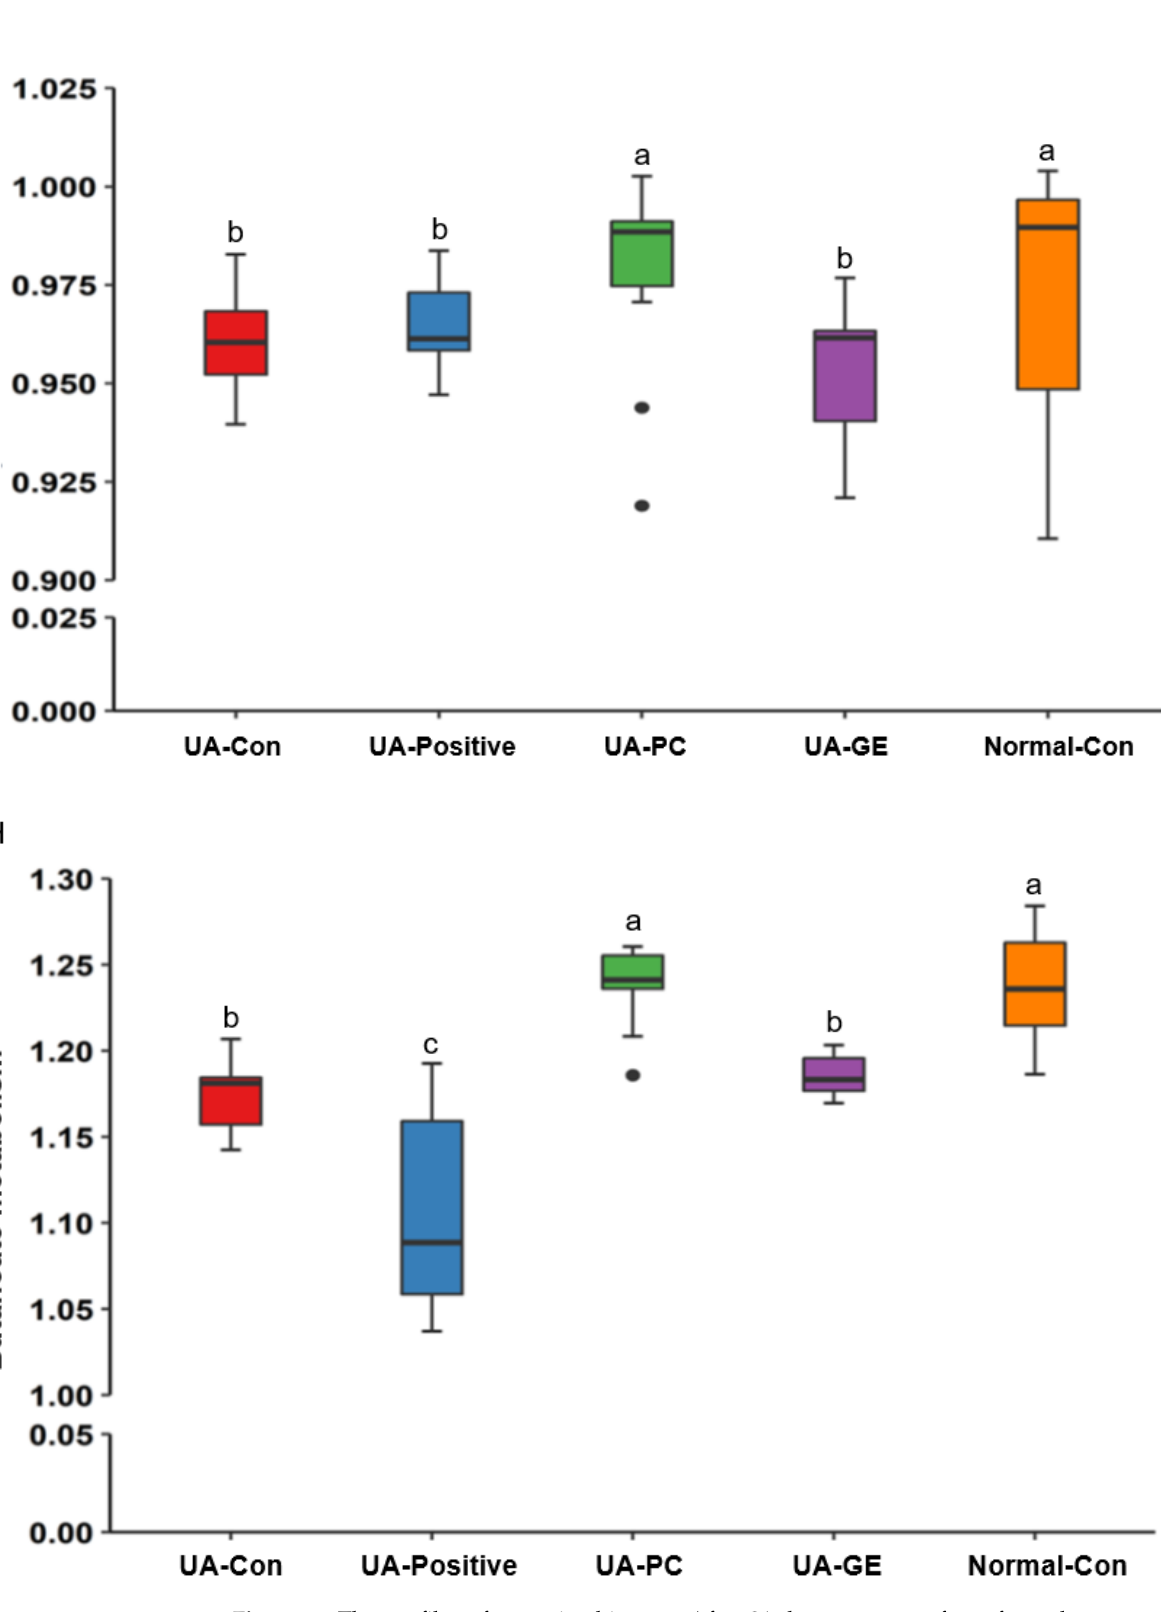
Figure 5. The profiles of gut microbiomes. After 21-day treatment, feces from the cecum were collected, and their bacterial DNA was analyzed by the next-generation sequencing method. ( A ) The relative amount (%) of fecal bacteria in the genus level. ( B ) Chao1 index. ( C ) Shannon index. ( D ) The principal coordinate analysis (PCoA) of fecal bacteria. ( E ) Pyruvate oxidation, pyruvate,